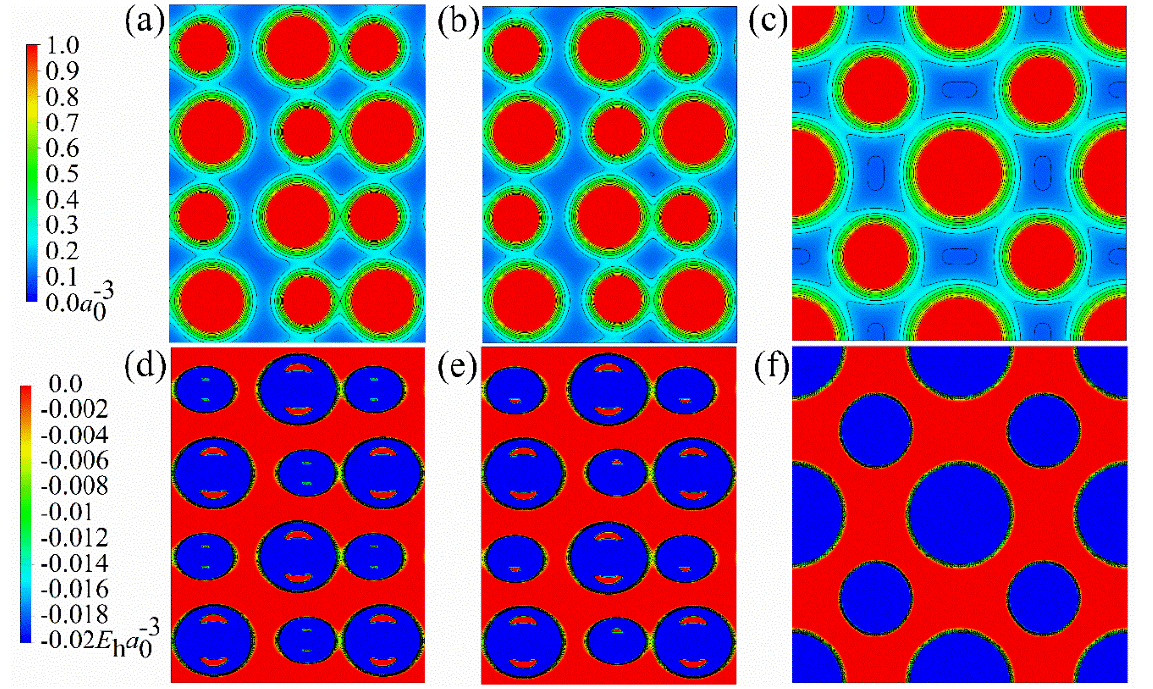
Figure 9. ( a – c ) Electron-density distribution on a plane in the main lattice of La 1 − x Ce x CoO 3 of different models. ( a ) a (011) plane of the rhombohedral lattice, ( b ) a (011) plane of the monoclinic lattice, and ( c ) a (011) plane of the cubic lattice. Contours are plotted up to 1.0 a 0 − 3 , with an interval of 0.1 a 0 − 3 . a 0 = 0.529177211 Å ( a 0 : Bohr radius). ( d – f ) Electronic energy map of the corresponding plane in ( a – c ). Contours are plotted down to − 0.02 E h a 0 − 3 , with an interval of − 0.002 E h a 0 − 3 . E h = 4.3597443 × 10 − 18 J ( E h: